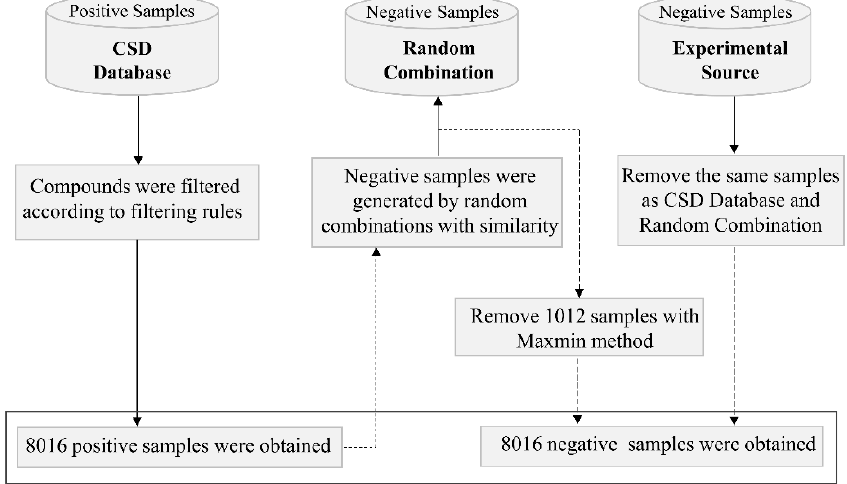
Figure 1. The whole workflow for dataset processing.